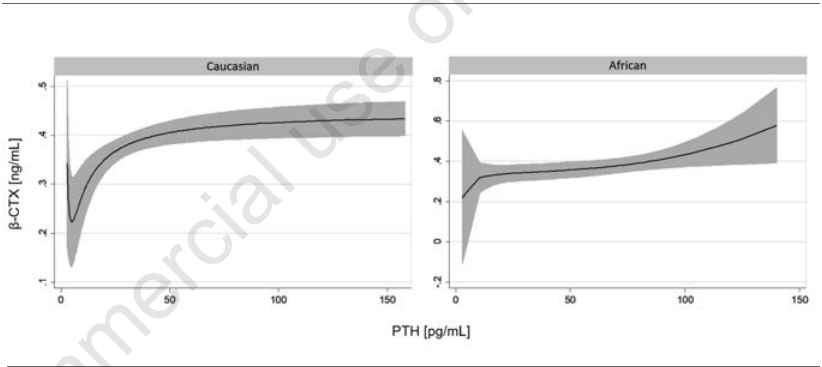
Figure 2. Fitted polynomial plots on the relation of vitamin D and -CTX concentra- tions. The black line represents the fitted, polynomial smoothened association of vitamin β D (25-OH-Cholecalciferol) with -CTX concentration per ethnicity. The grey area rep- resents the predicted 95% confidence interval. β